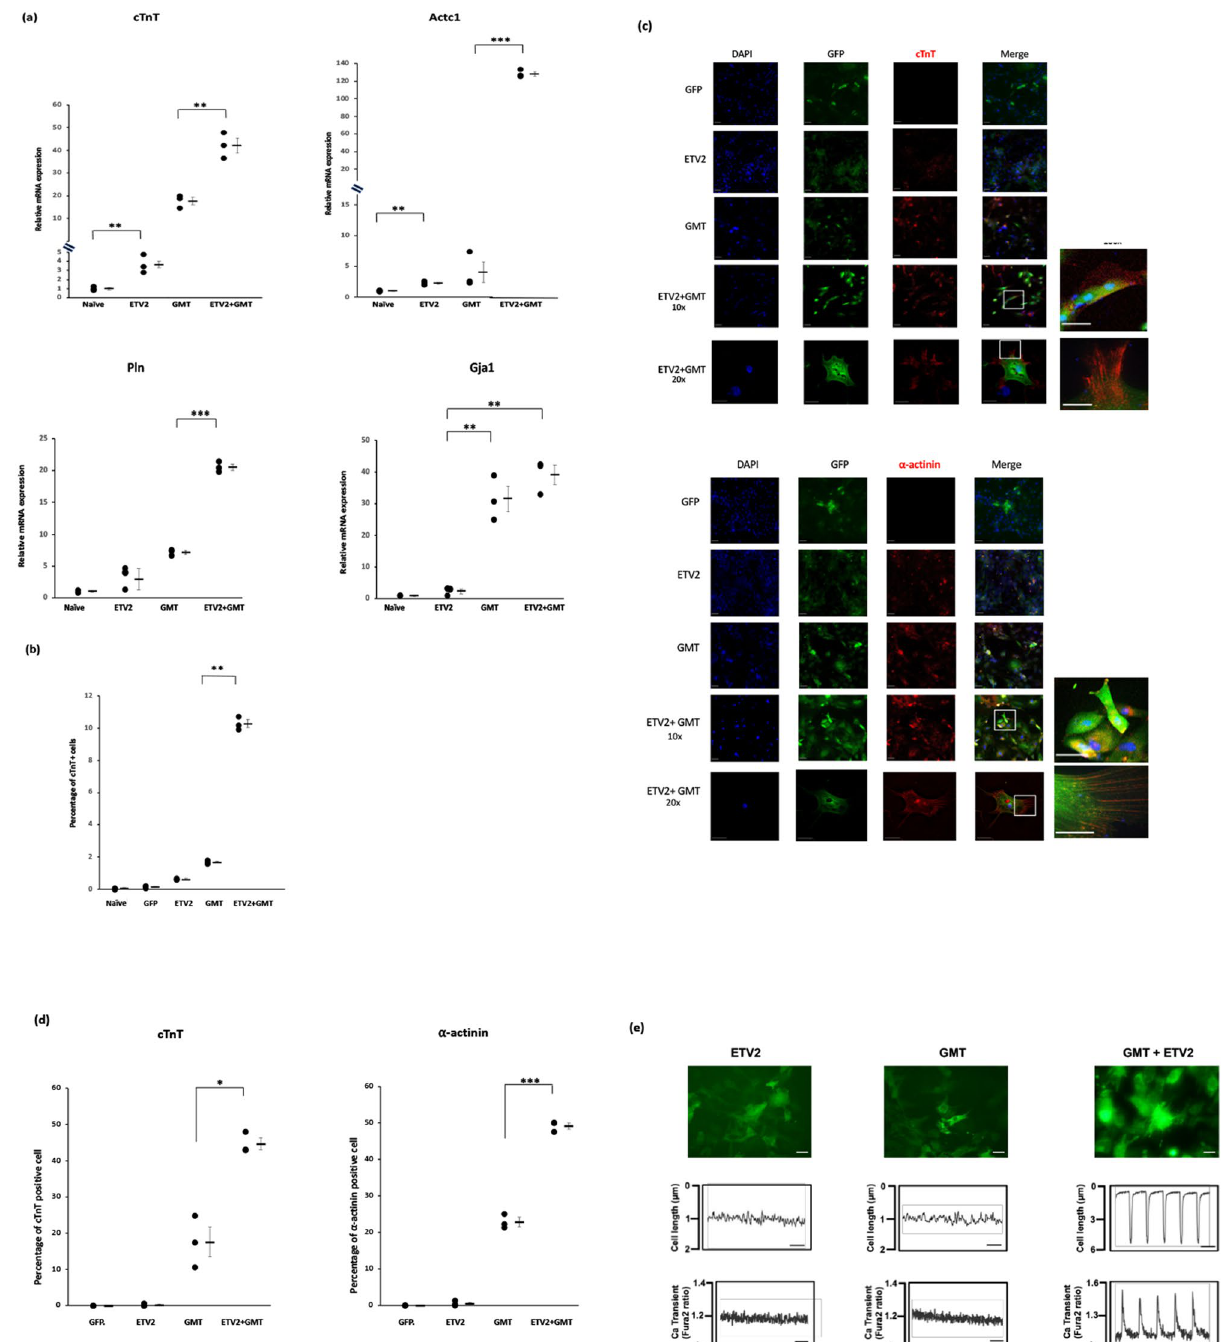
Figure 3. ETV2 induction prior to GMT treatment enhances the reprogramming of rat cardiac fibroblasts into cardiomyocyte-like cells. Rat cardiac fibroblasts were treated with doxycycline with or without lentivirus encoding ETV2 and rtTA. Three days after doxycycline withdrawal, cells were treated for 14 days with lentivirus encoding GFP or GMT (n = 3). ( a ) qPCR analysis demonstrating increased expression of the cardiomyocyte markers cTnT (**p < 0.01) as well as Actc1 and Pln (***p < 0.001) in ETV2 + GMT treated cardiac fibroblasts compared to cells treated with GMT alone. ( b ) Quantification of FACS data demonstrating an increased percentage of cTnT + cells after ETV2 + GMT treatment vs treatment with GMT alone (**p < 0.01). ( c ) Immunostaining demonstrating the increased prevalence of cTnT and α-actinin in cells treated with ETV2 + GMT compared to cells treated with GMT alone. Sarcomeric filament structure was clearly identified in GMT + ETV2 groups but not in cells treated by GMT alone. High magnification views shown on the right side (top: × 40, bottom: × 100). Scale bar: 100 μm. ( d ) Quantification of immunostaining demonstrating increased number of cTnT-positive (*p < 0.05) as well as α-actinin-positive (***p < 0.001) cells in ETV2 + GMT treated cardiac fibroblasts compared to cells treated with GMT alone. ( e ) Cell contractility assessments of ETV2 (left), GMT (middle) and ETV2 + GMT (right) treated cells, as described in “Methods”. Two weeks after treatment with GFP-labeled reprogramming vectors, rat cardiac fibroblasts were transferred into co-culture with (untreated) neonatal rat cardiomyocytes (negative for GFP). Upper panel demonstrating GFP expression (green) of treated cells after 6 weeks in co-culture. Scale bar 100 μM. Lower panel demonstrating representative peaks from GFP-positive cells reflecting contraction (top row) and Ca 2+ transients (bottom row) in cells treated with GMT + ETV2. Scale bar 0.5